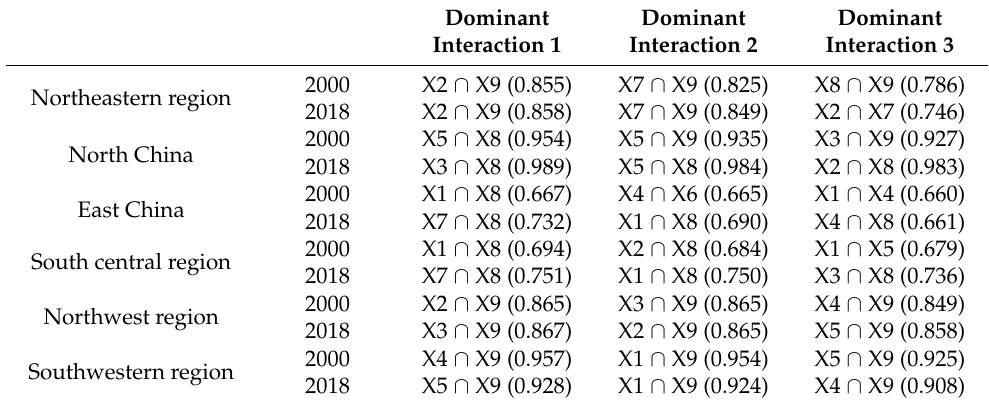
Table 6. Dominant interactions between two variables in different